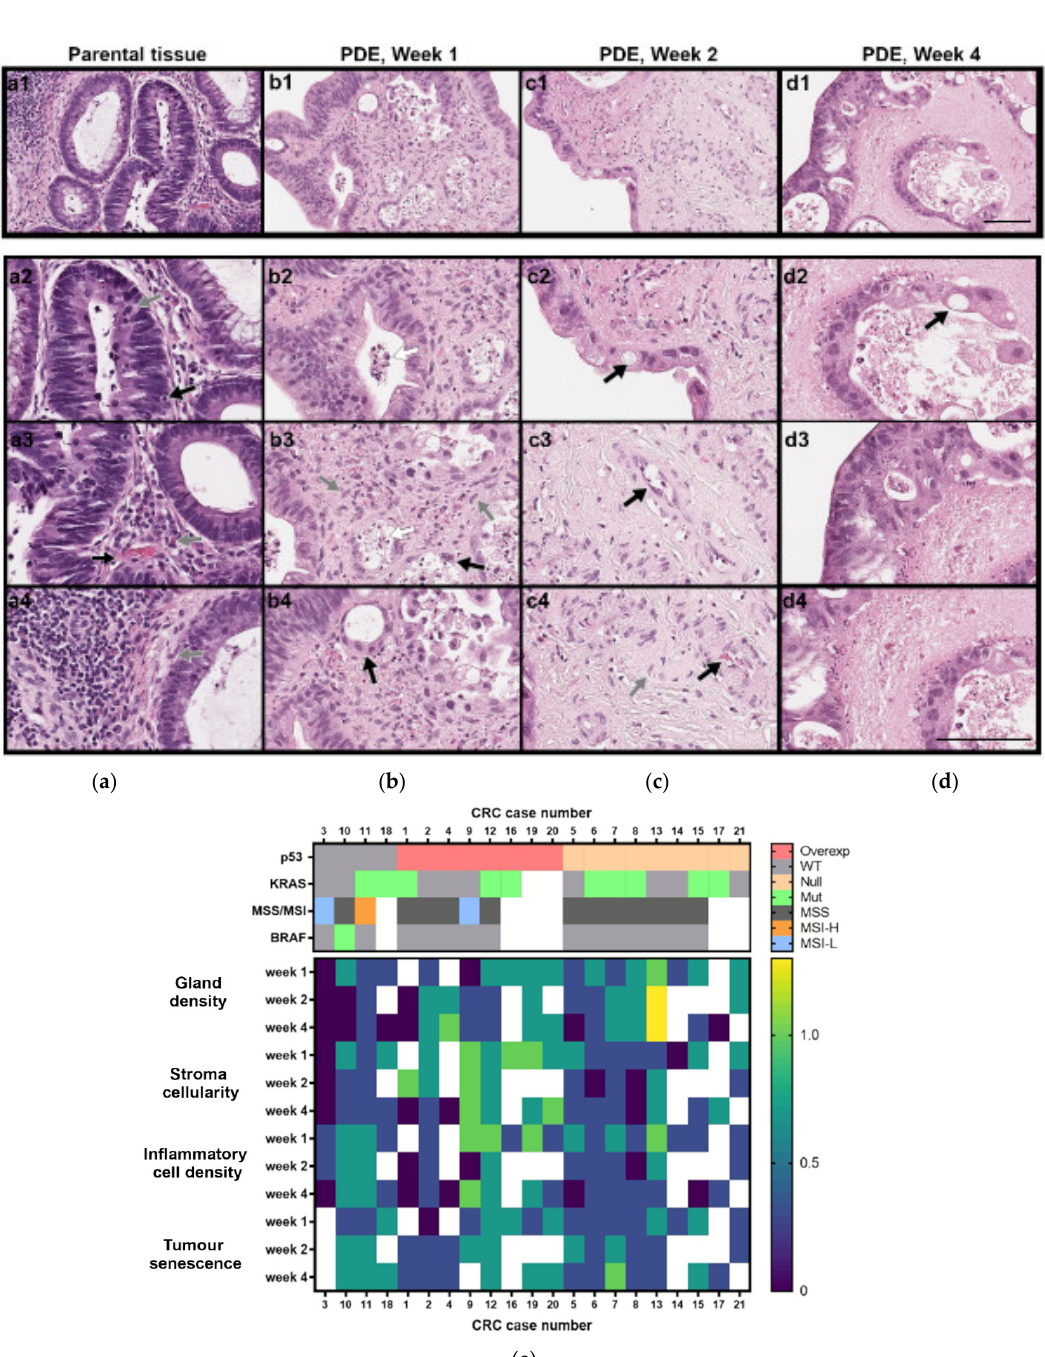
Figure 3. Histopathological and molecular characterisation of CRC-PDE cultures. ( a – d ) Representative HE images of the parental tumour and derived explants (PDE) over 4 weeks of culture (for case CRC2). Gland-forming tumour cells ( a1 – a3 , b2 , d3 ), mitotic cells ( a2 , grey arrow), vascular stroma ( a3 , c3 , black arrows), stromal fibroblast ( a4 , b3 , c4 , grey arrows), tumour infiltrating lymphocytes ( a2 , black arrow) and plasma cells ( a3 , grey arrow), erythrocytes ( c4 , black arrow), senescent cells ( b3 , b4 , c2 , d2 , black arrows), necrotic cells ( b2 , b3 white arrows), acellular stroma ( d4 ). Scale bars, 100 µ m. ( e ) Heatmap of the histopathological features along culture time (week 1—days 7–9; week 2—days 14–17; week 3: days 25–28) and mutation and protein alterations associated with CRC carcinogenesis, for the 21 CRC cases analysed. Scores for morphological features were performed considering day 0 of culture as the reference and scored as 1 for gland density, stroma cellularity and inflammatory cell density and as 0 for senescence evaluations. White boxes indicate not determined. CRC, colorectal cancer; CRC-PDE, colorectal cancer patient-derived explants; MSS, microsatellite stable; MSI-L, microsatellite instability-low; MSI-H, microsatellite instability-high; Mut, mutated; Overexp, overexpressed; WT, wild